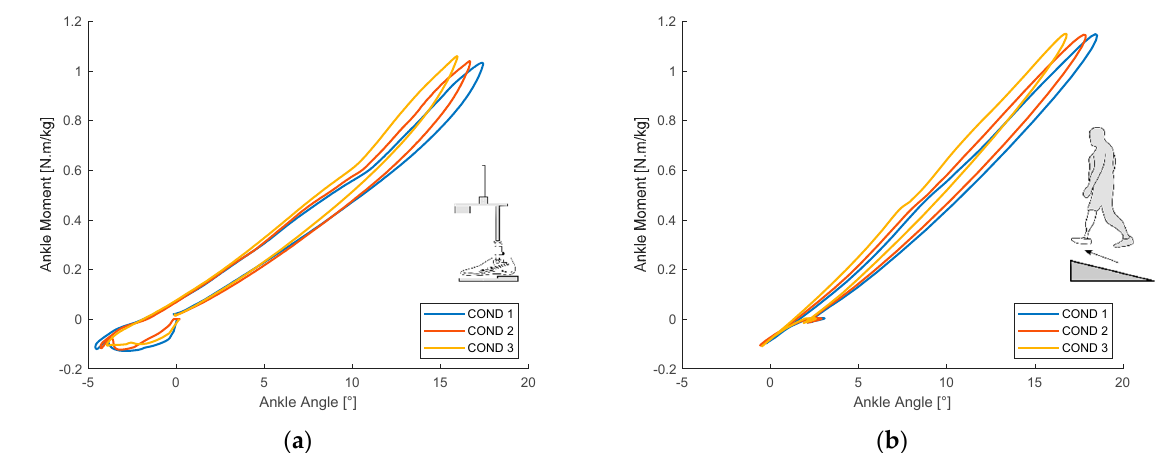
Figure 8. Ankle moment versus ankle angle during 7.5° incline walking for three stiffness settings-condition 1 (softest), con- dition 2 (mid), and condition 3 (stiffest): ( a ) test machine results and ( b ) biomechanical test results–average of five users. The decline-walking prosthetic foot ankle moment and angle results for the machine and biomechanical tests are shown in Figure 9.